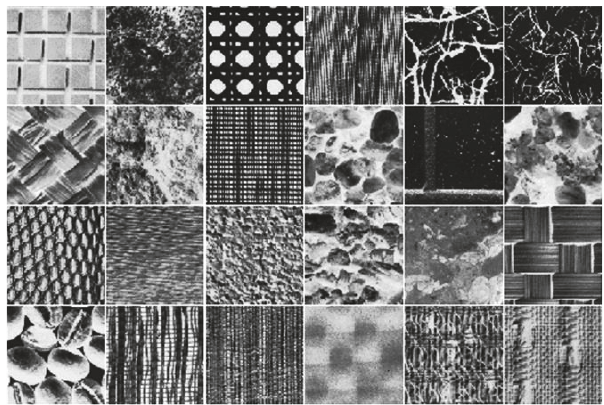
Figure 8: 24-class small-scale Brodatz data set B Sc .